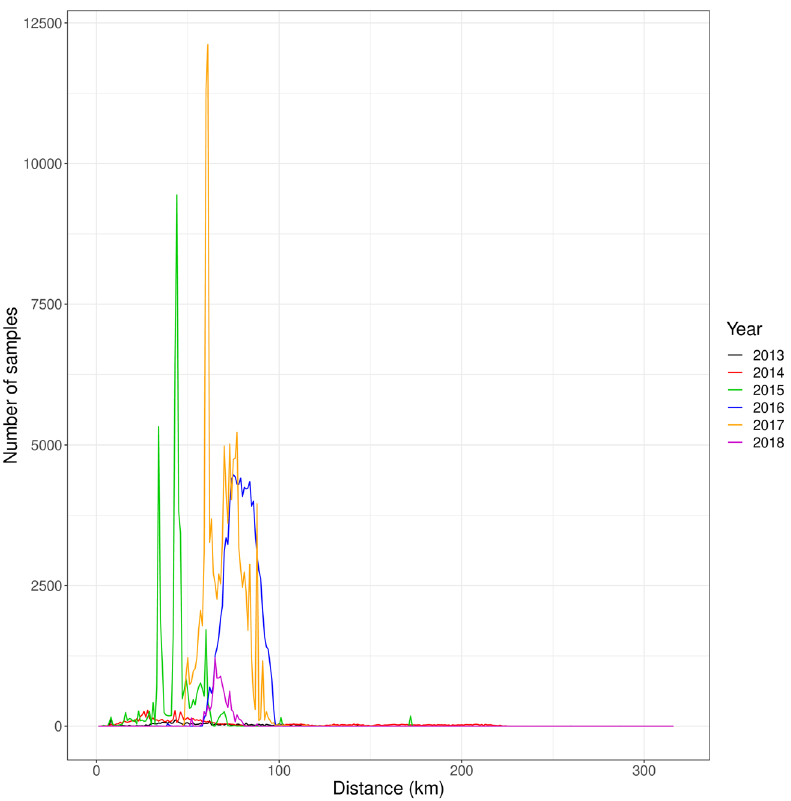
Figure 3. Sampling intensity in the Puglia region. The number of samples is given for each 1 km-wide ring as a function of distance to the town of Gallipoli, the presumed origin of the